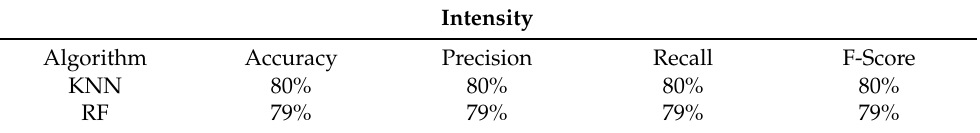
Table 4. Alternative 2—Intensity